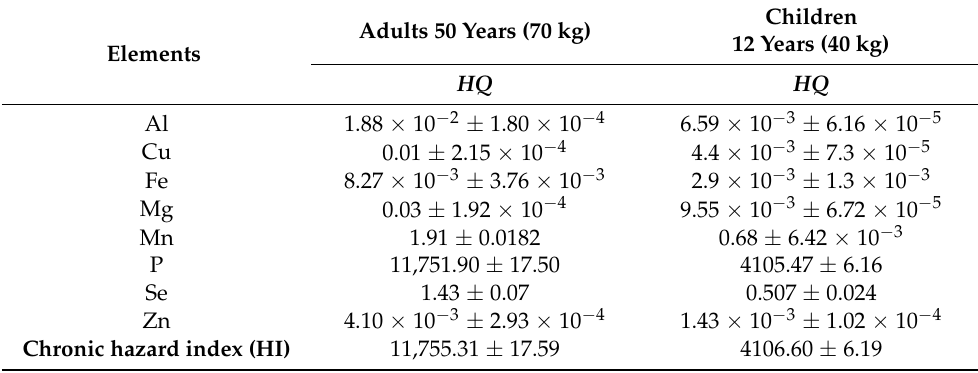
and children and chronic hazard index